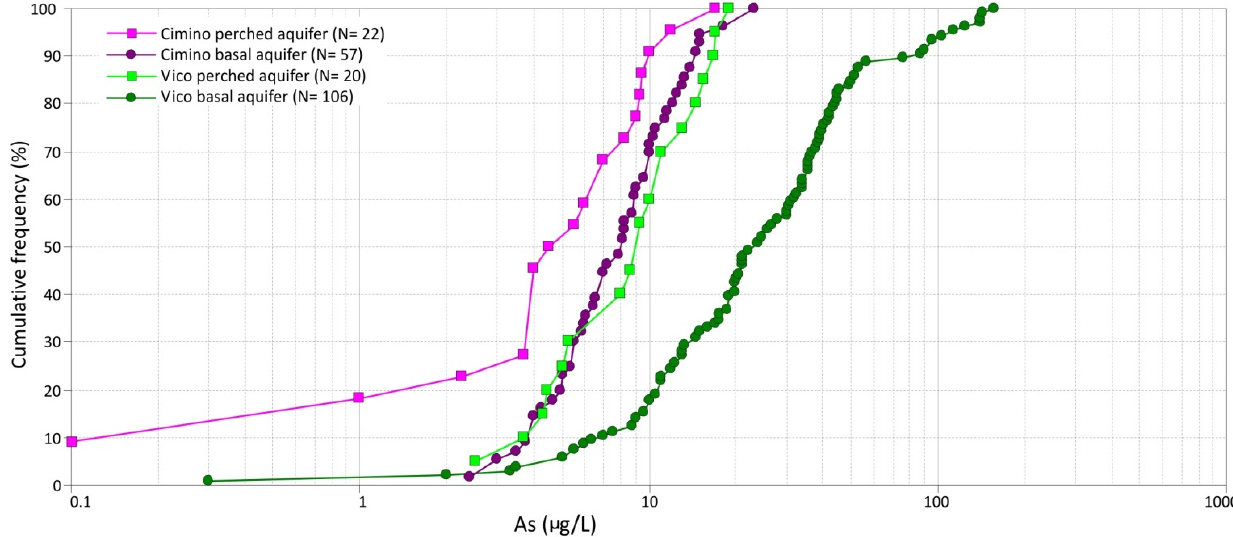
Figure 5. Cumulative frequency plots of arsenic concentrations in groundwater of the Cimino and Vico volcanic